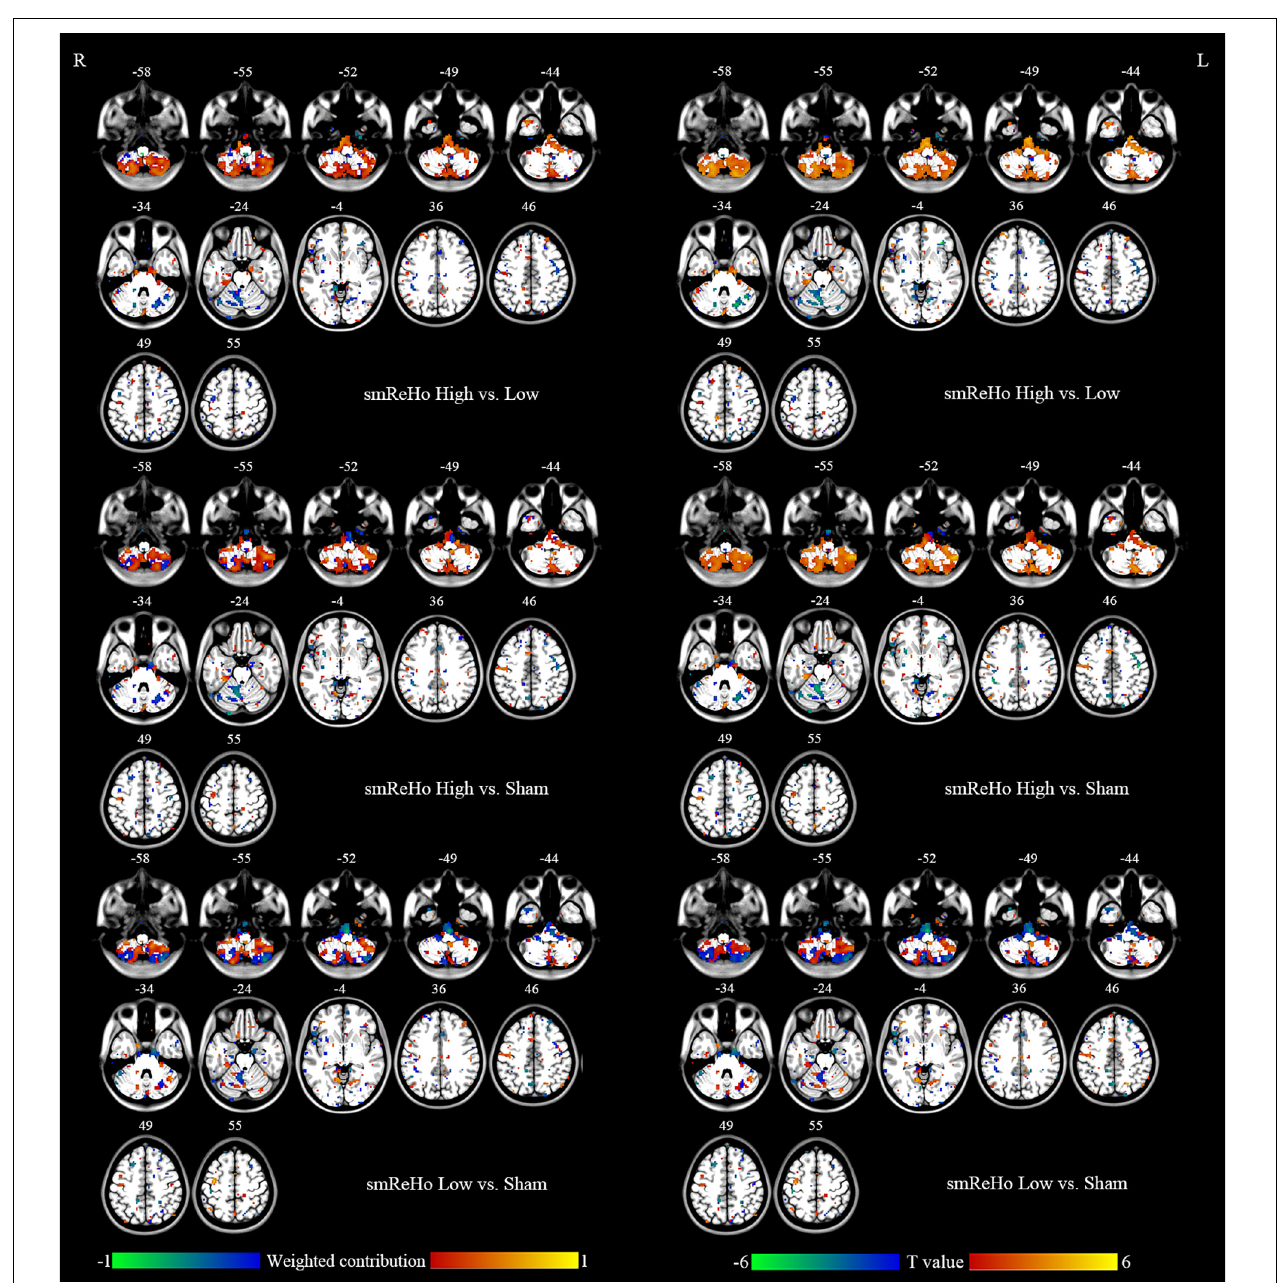
FIGURE 5 | Left column: Brain regions that showed different contributions between stimulation conditions identified by ReHo maps within the mask of uncorrected F map of ANOVA. Right column: Paired t tests between stimulation conditions on ReHo maps within the mask of uncorrected F map of ANOVA.